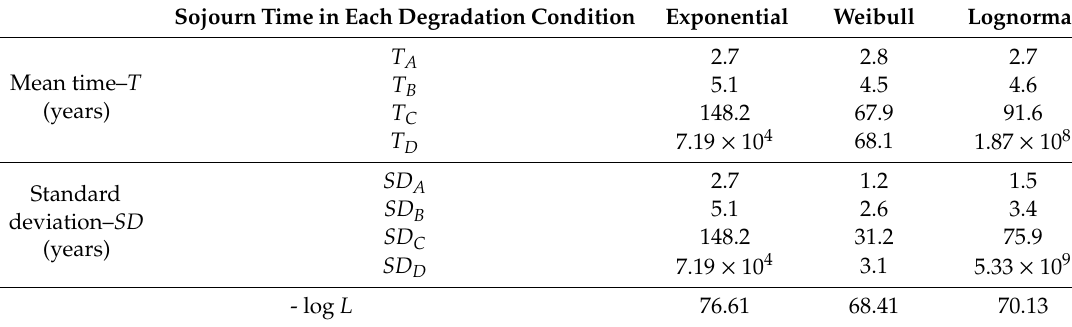
Table 2. Optimal parameters.